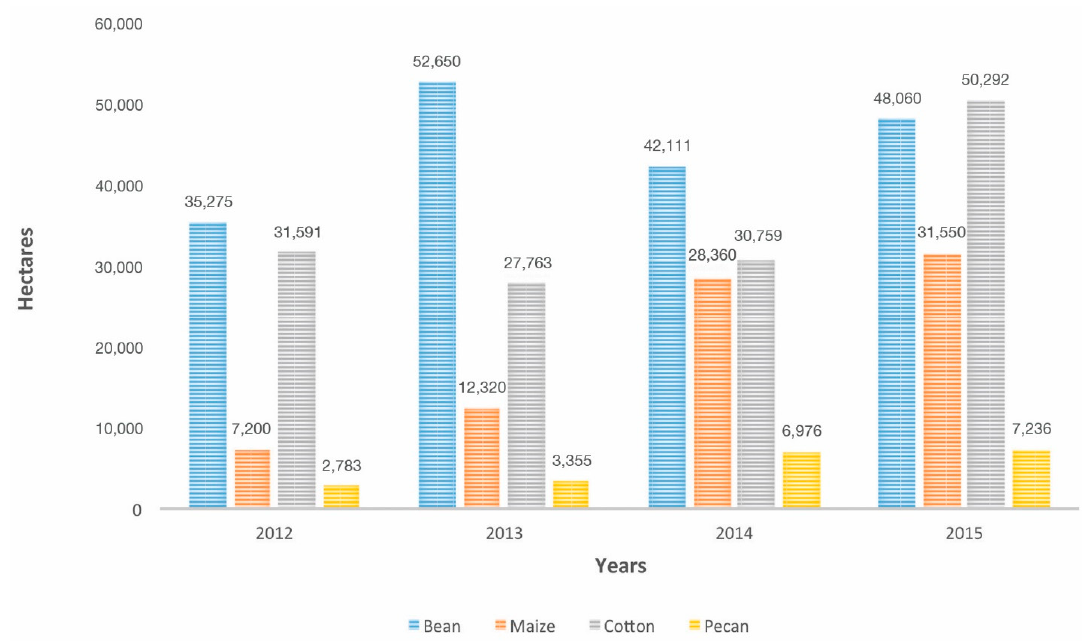
Figure 7. Hectares sown with the main crops in the key municipalities that make up the Rio del Carmen watershed, from 2012–2015. Information obtained from INEGI,